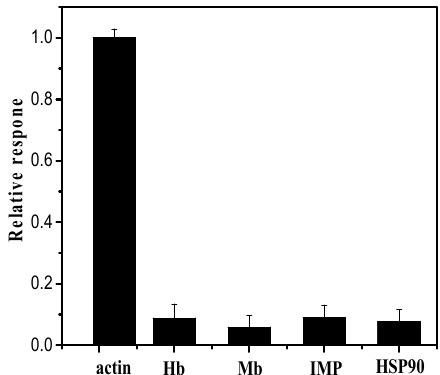
Figure 6. Detecting interference in solution containing Hb, Mb, IMP and HSP90 respectively. It is an average value of the response of three measurements for each sample by defining the signal of actin as 100%.